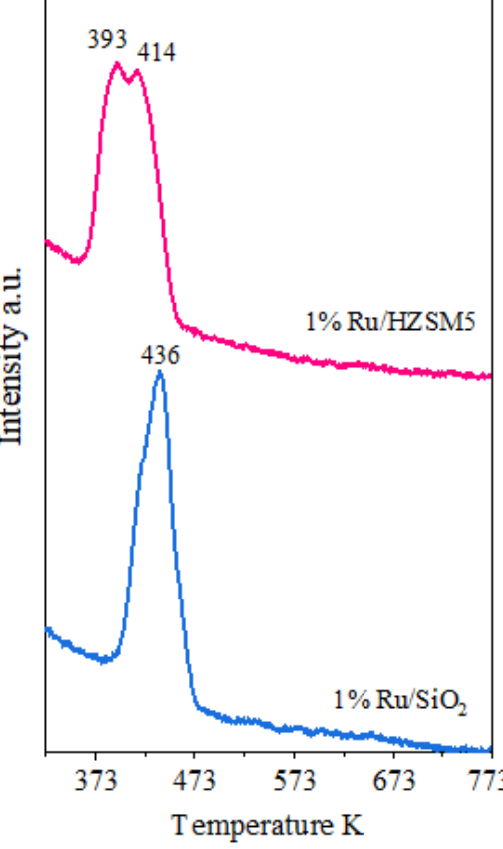
Figure 4. TPR profiles of ruthenium-supported catalysts.